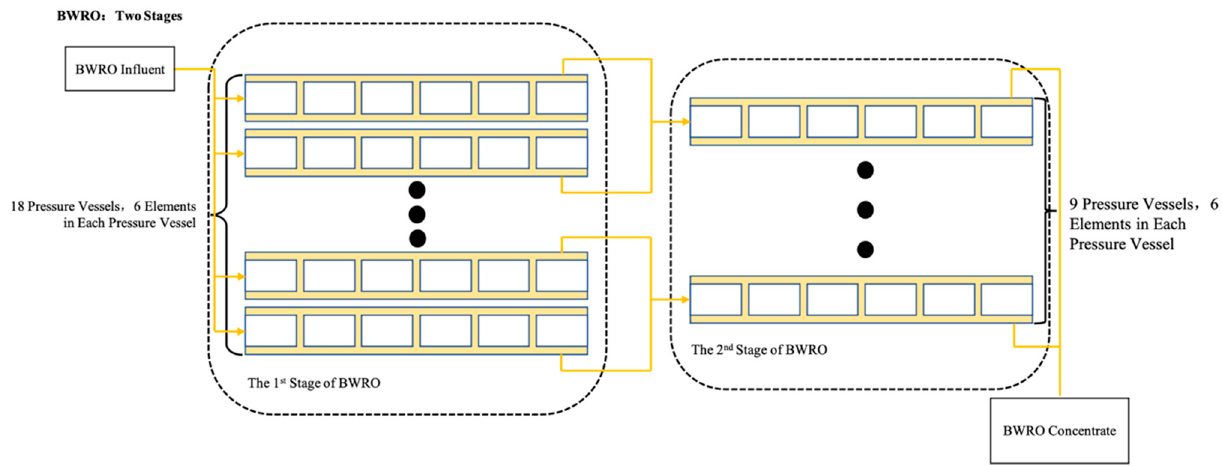
Figure 2. BWRO membrane assembly arrangement.